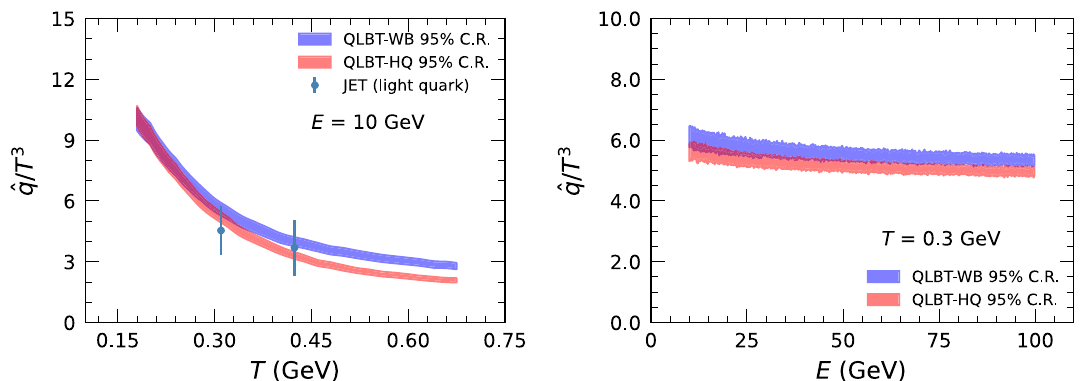
Fig. 8 Temperature (Left) and energy (Right) dependent charm quark transport coefficient ˆ q / T 3 obtained using two different g ( T ) extracted from WB and HQ lattice QCD data